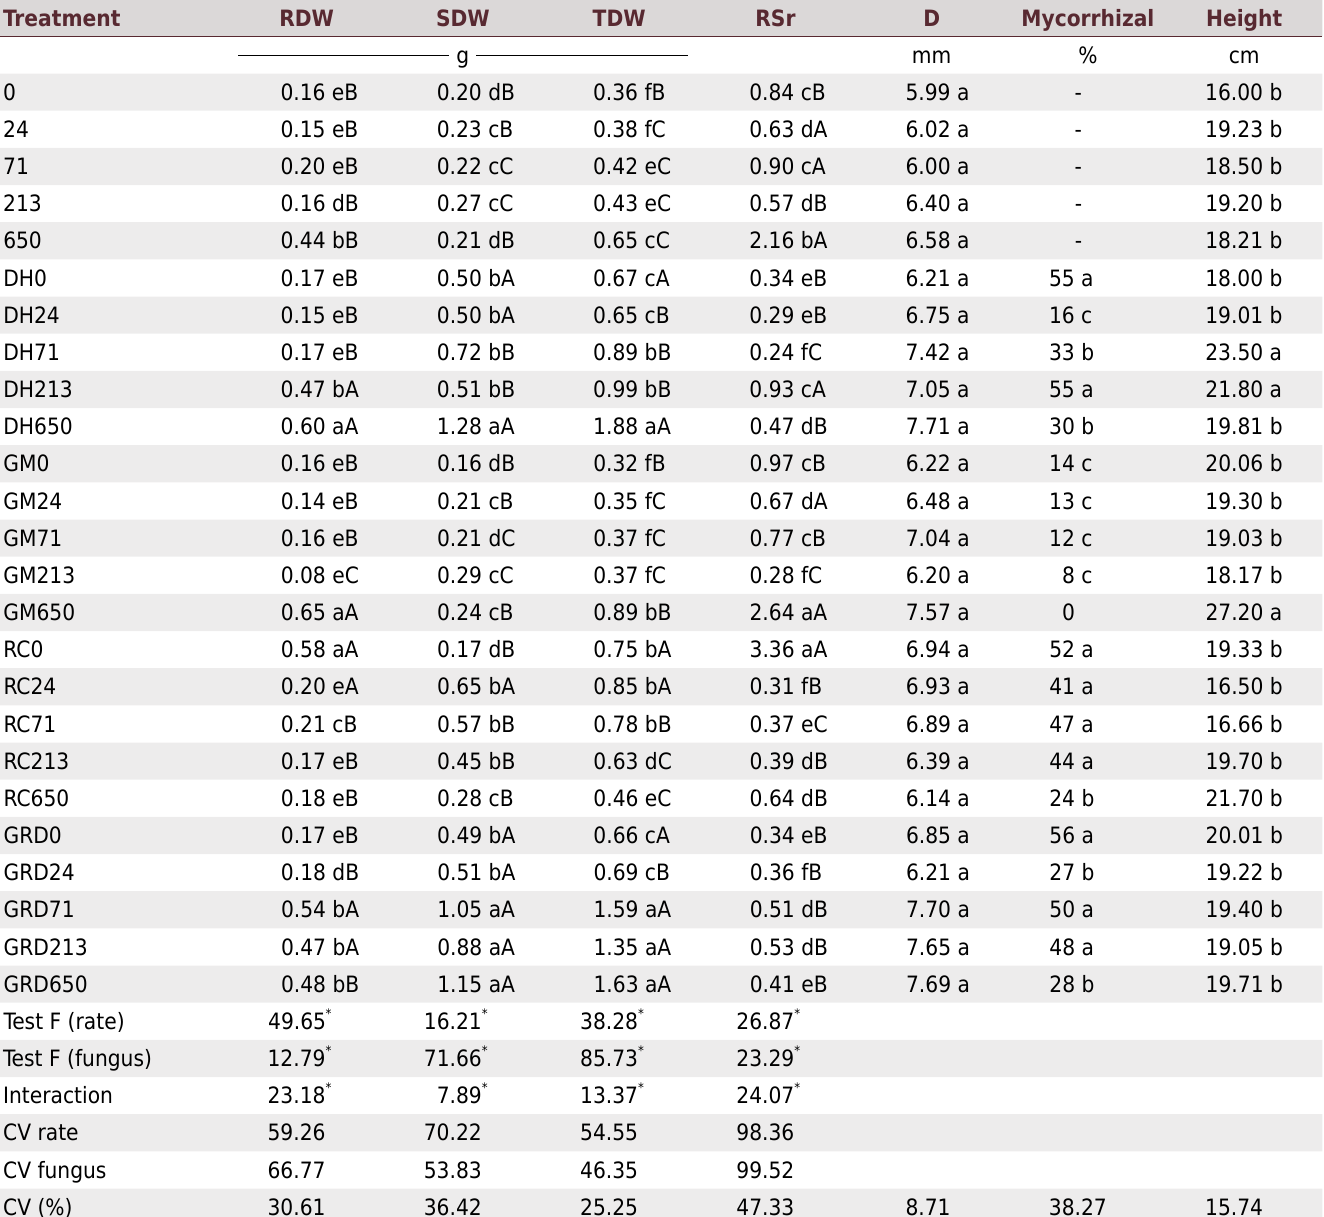
Table 2. Growth of Apuleia leiocarpa seedlings inoculated with different arbuscular mycorrhizal fungi (AMF), combined with five phosphorus rates